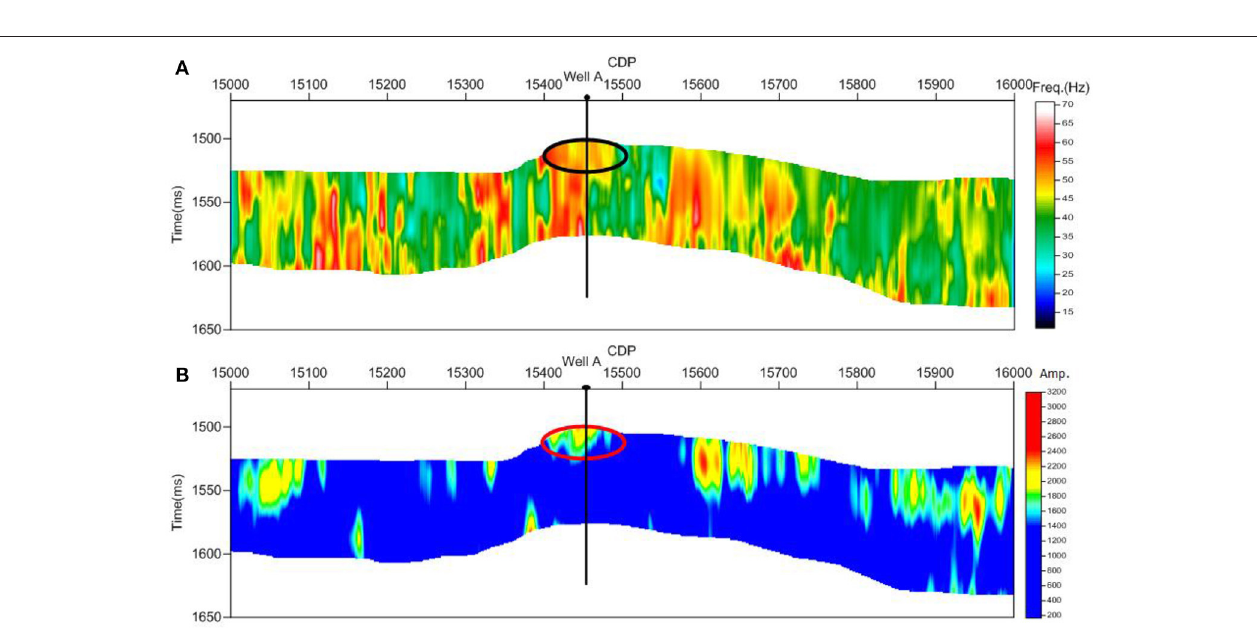
FIGURE 10 | The peak frequency and the maximum amplitude at each time sample above the average amplitude extraction using the EMD-based HT. (A) The seismic signal at CDP stacked trace 15454 intersecting well A. (B) The peak frequency with maximum energy at each time sample. (C) The maximum amplitude at each time sample above the average amplitude.